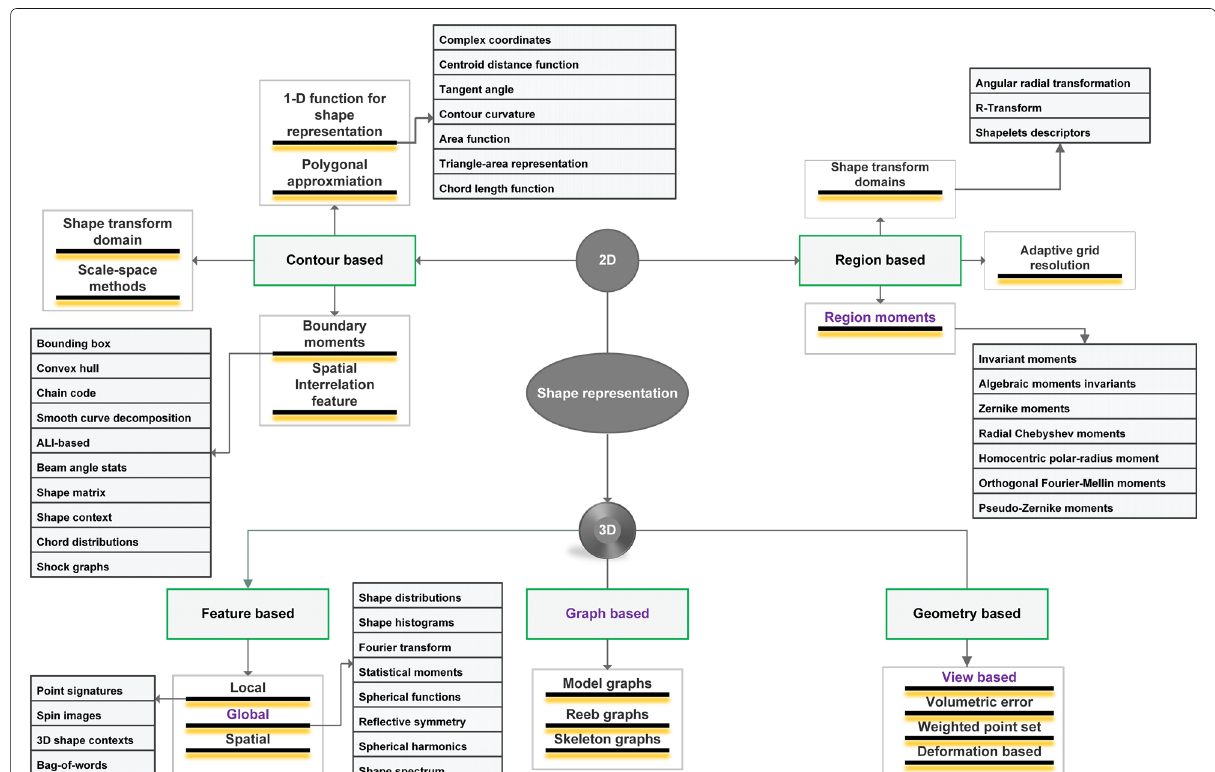
Fig. 1 Taxonomical classification of shape analysis techniques. At the root, they can be classified based on dimensionality of the model (2D or 3D). The proposed approach is a combination of region, feature, and graph-based method as highlighted with